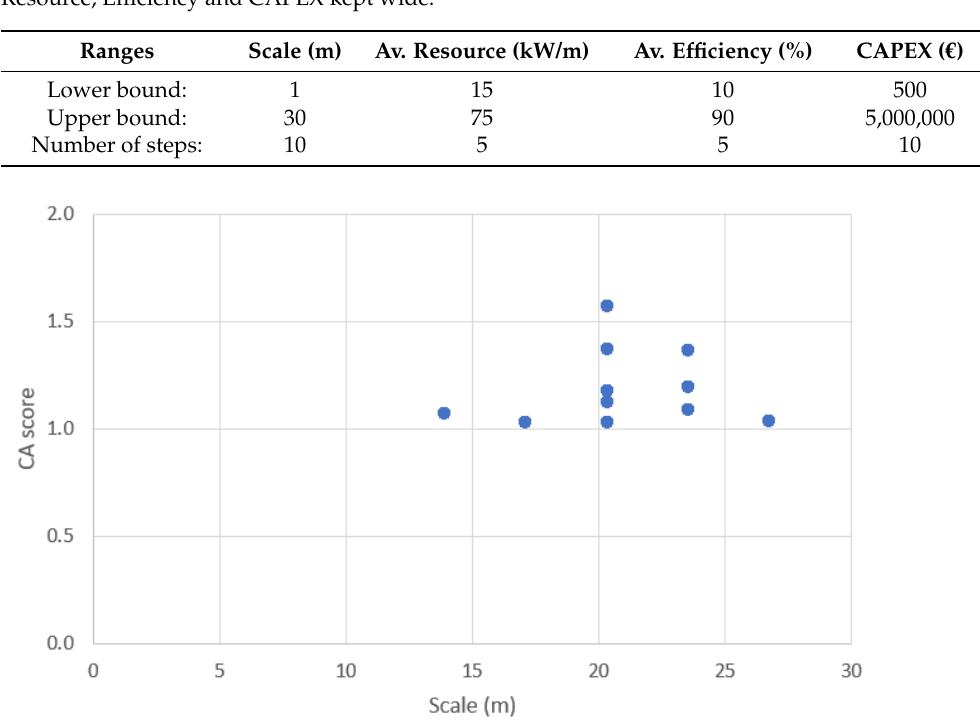
Table 11. Input ranges chosen for the zoomed in scale scenario (1–30 m) with the other ranges of Resource, Efficiency and CAPEX kept wide.